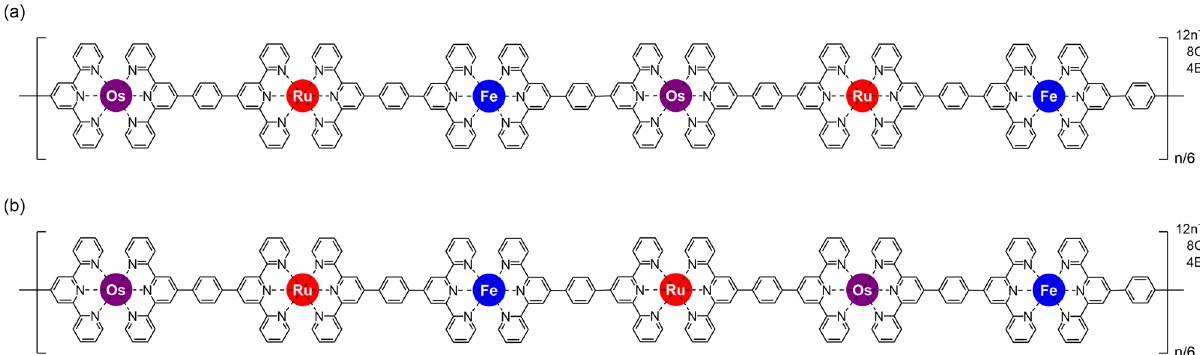
Fig. 3 Possible chemical structures of polyOsRuFe. a Head-to-tail structure and b head-to-head and tail-to-tail structure